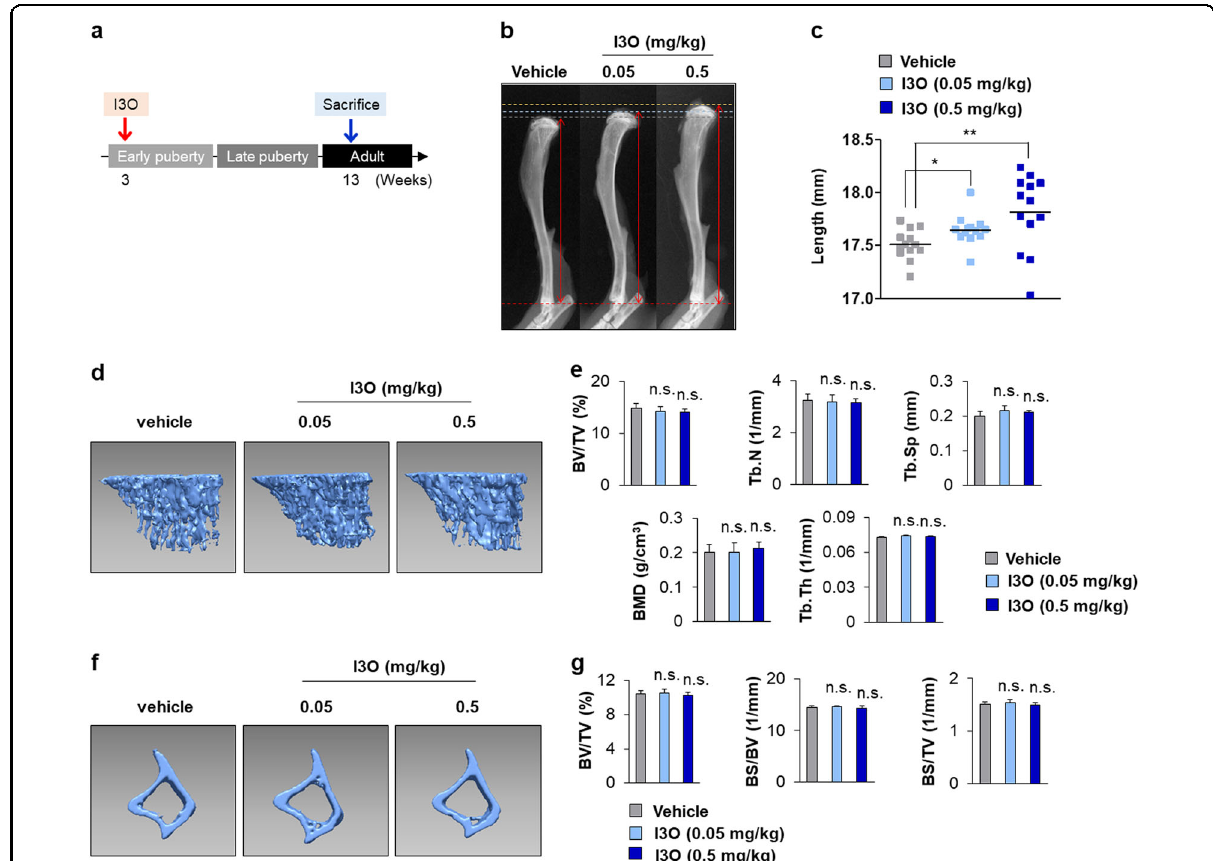
Fig. 5 The effects of long-term treatment with I3O on tibia length and bone parameters. a – g I3O (0.05 and 0.5 mg/kg) was administered to 3- week-old mice daily by intraperitoneal injection for 10 weeks. Schematic diagram of in vivo experiments a . Representative radiographs are shown b along with the tibia length measurements (mean ± s.e.m., n = 13 per group, * P < 0.05, ** P < 0.005) c . Representative μ CT images of tibial trabecular bones d and their parameters, such as bone volume to tissue volume ratio (BV/TV), bone mineral density (BMD), number of trabeculae, and trabecular separation (mean± s.e.m., n = 5 per group) e . Representative μ CT images of tibial cortical bones f and their parameters, such as bone volume to tissue volume ratio (BV/TV), bone surface to bone volume ratio (BS/BV), and bone surface density (BS/TV) (mean± s.e.m., n = 5 per group) g . n.s. indicates non-signi fi cance compared with